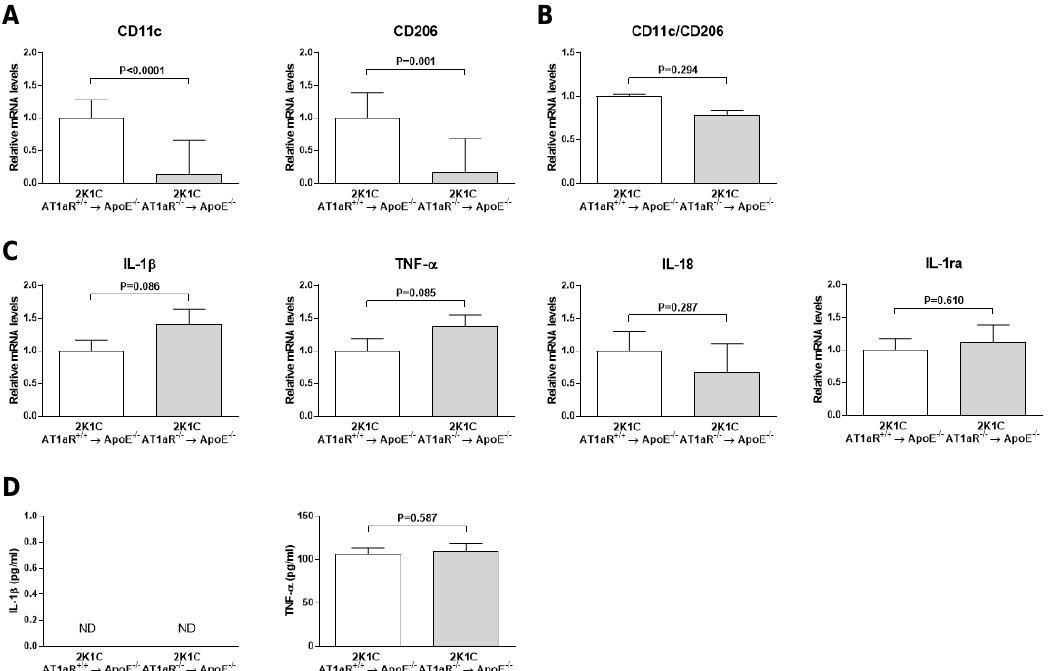
Figure 8. Effect of AT1aR deficiency in BM-derived cells on the systemic expression of macrophage phenotype